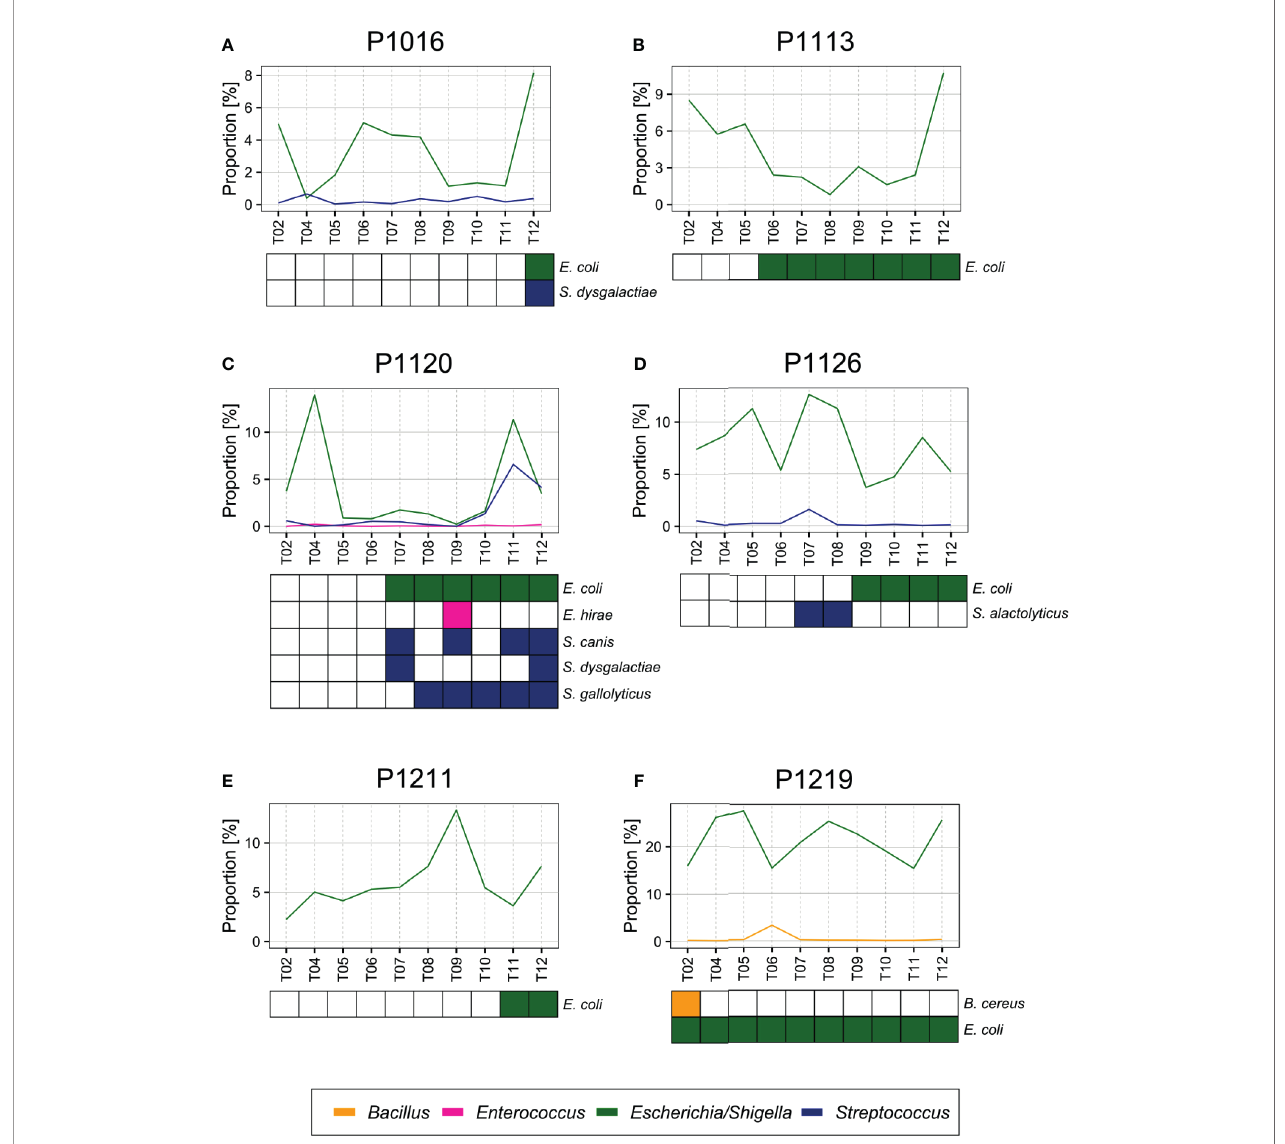
FIGURE 5 | (A – F) Bacteria detected by blood culture. E. coli and other species ( Streptococcus dysgalactiae , Enterococcus hirae, Streptococcus alactolyticus , Streptococcus gallolyticus , and Bacillus cereus ) con fi rmed previously by blood culture (Park et al., 2019) were also detected by blood microbiome sequencing from each